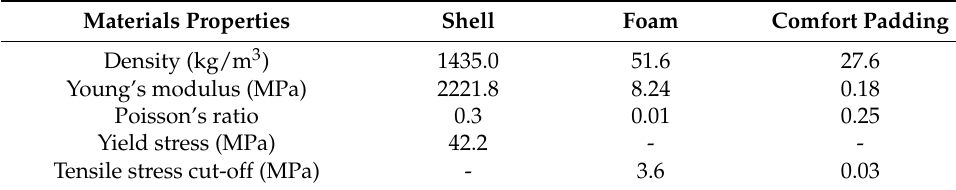
Table 1. Mechanical properties of each structural